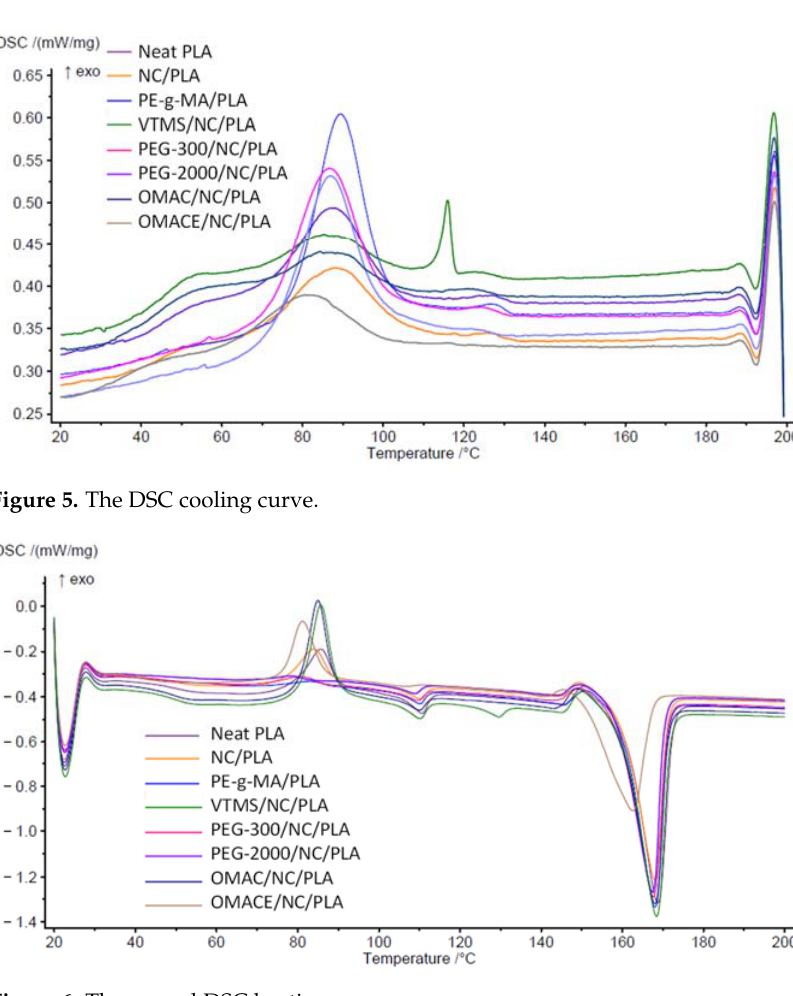
Figure 6. The second DSC heating curve. Table 4. The main properties of composites based on DSC